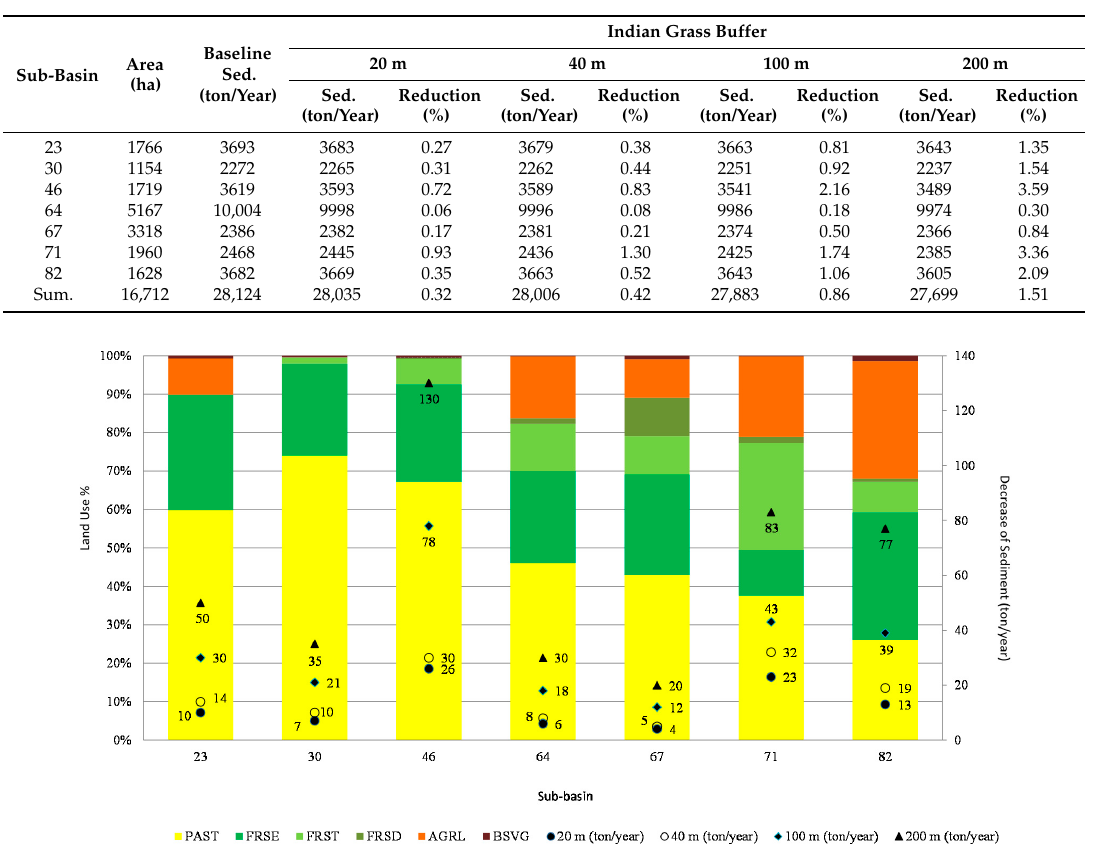
Figure 6. Decrease of sediment delivery per sub ‐ basin (and landuse designation breakdown), demonstrating the implementation of varying buffer strip